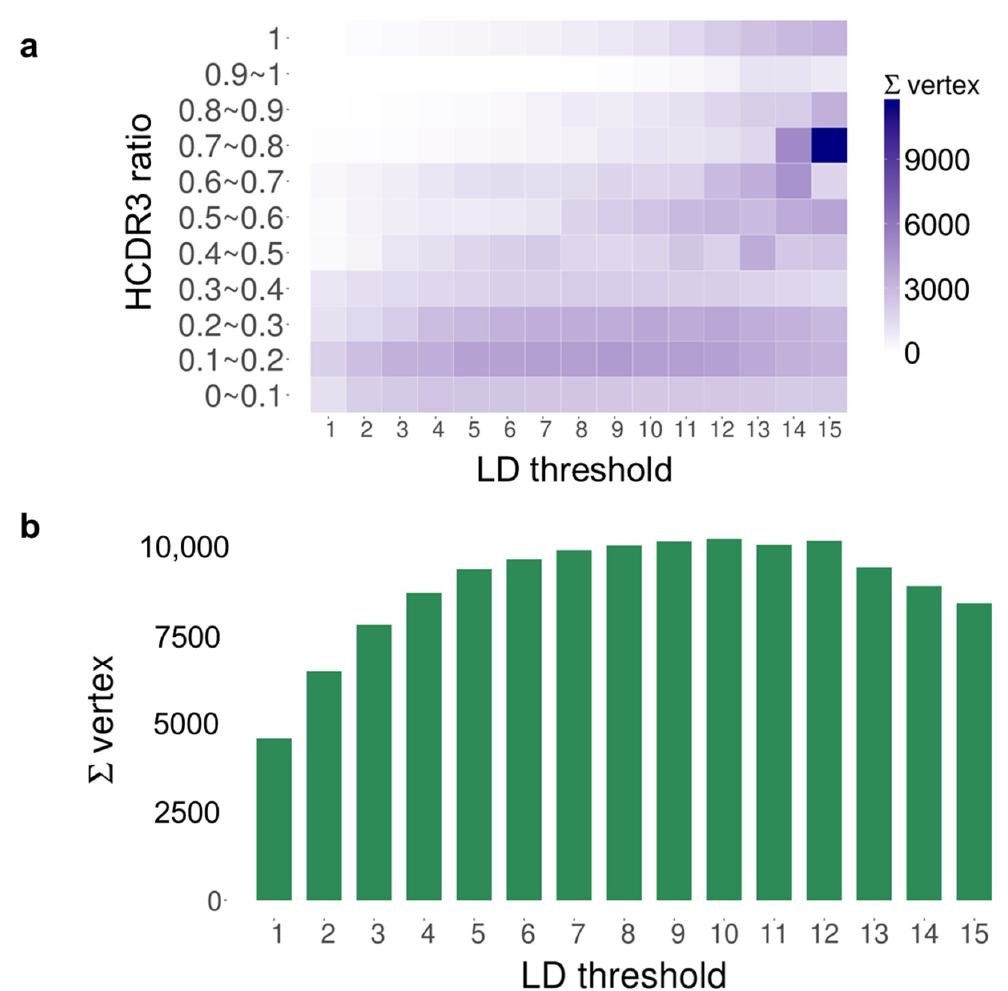
Figure 1. Formation of components depending on the Levenshtein distance (LD) threshold. ( a ) The HCDR3 (CDR3 of V H ) ratio (y-axis) indicates the number of unique complementary determining region 3 (CDR3) amino acid sequences divided by the number of vertices in each component. The heatmap shows the total number of vertices belonging to multiple components within the same range of the HCDR3 ratio. For LD thresholds from 4 to 15, the number of vertices in components with an HCDR3 ratio of 0.1–0.2 or 0.2–0.3 was significantly higher than that in components with an HCDR ratio of 0.3–0.4. Components with fewer than three vertices ( n = 2095 ) were excluded. ( b ) Histogram showing the total number of vertices in components with an HCDR3 ratio under 0.3. The maximum number of vertices was achieved with an LD of 12.